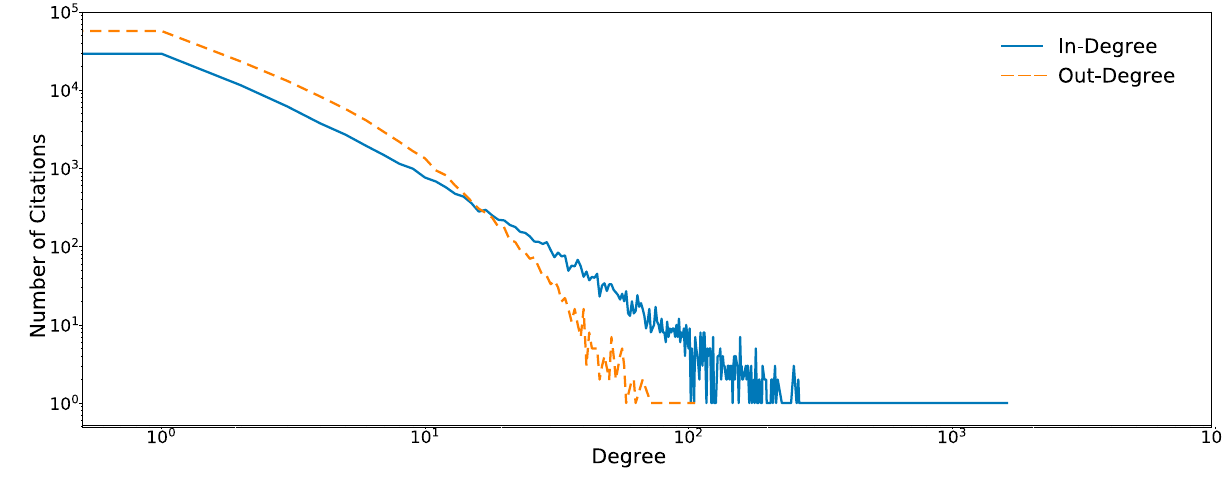
FIGURE 2 | Log-log distributions of inward and outward citations in the cross-jurisdictional